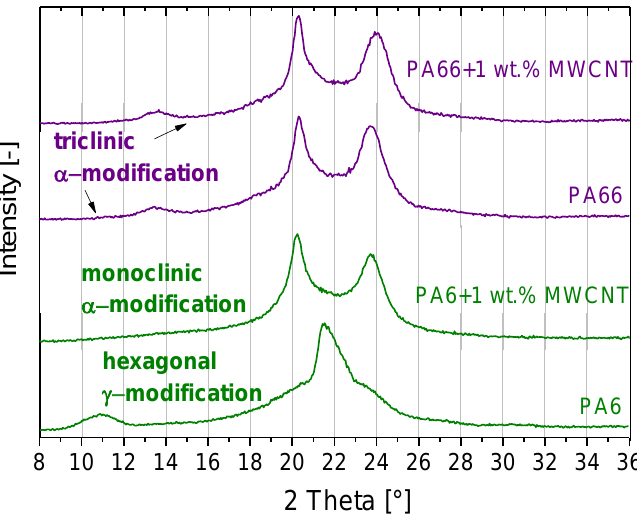
Figure 9. Diffractogram of PA6, PA66, and PA composites containing 1 wt % MWCNT.